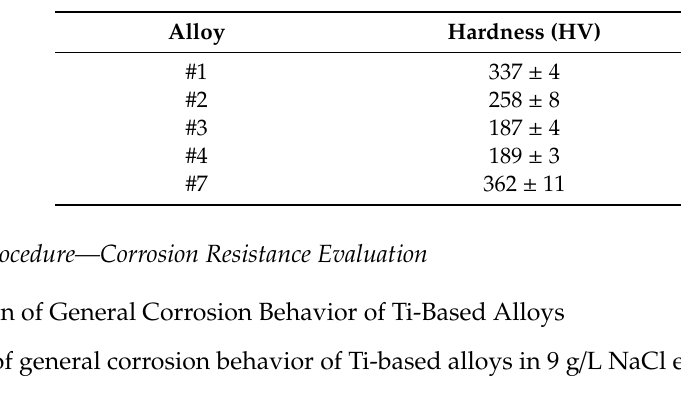
Table 4. Ti-based alloys’ micro-hardness values, (HV).